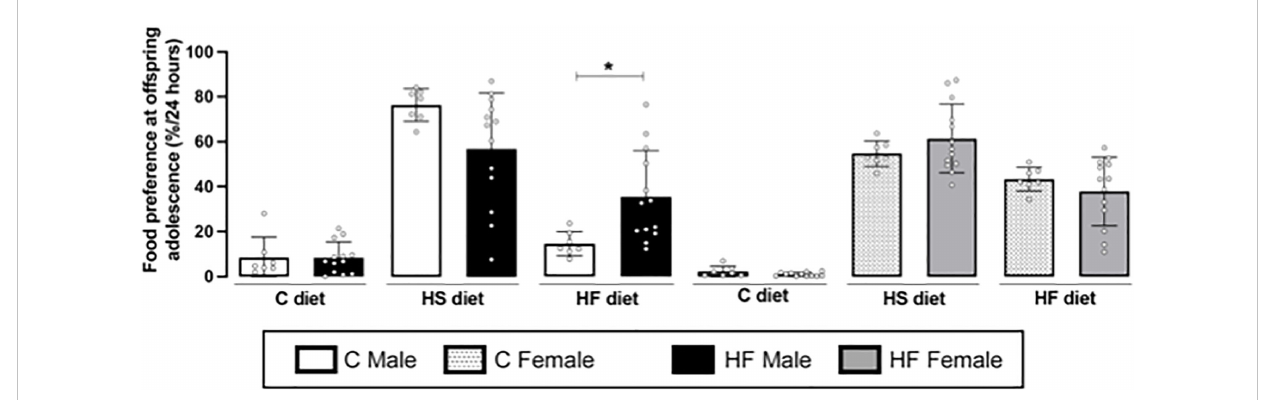
FIGURE 8 Effect of maternal high-fat (HF) diet on the food preference of rat offspring at adolescence. Intake of control (C) , high sucrose (HS) and HF diets of male and female offspring born from progenitors receiving control (C) or HF diet. Statistically signi fi cant differences were determined by unpaired Student ’ s t test. * p < 0.05